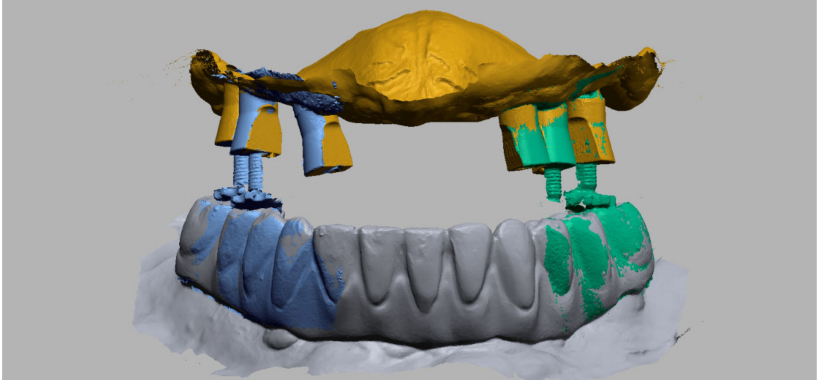
Figure 16. Same patient: A digital impression of the maxillary arch with dual-function scan bodies, a digital mandibular antagonist impression and two bilateral buccal bite-scans with adjusted bite pillars inserted into the screw holes of the dual-function scan bodies on multi-unit level (Geomagic Design X, 3D Systems Inc., Rock Hill, SC,